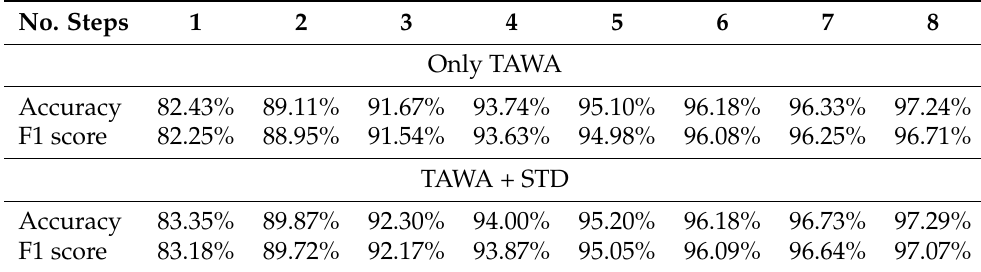
Table 2. Activity recognition results with respect to step